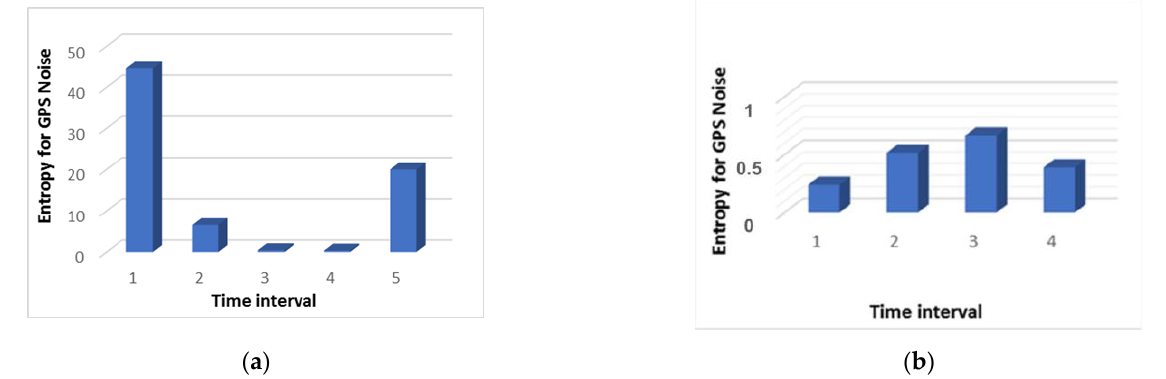
Figure 3. The result of measuring the Kullback-Leibler divergence of the GPS noise index: ( a ) During the attack; and ( b ) under normal conditions.